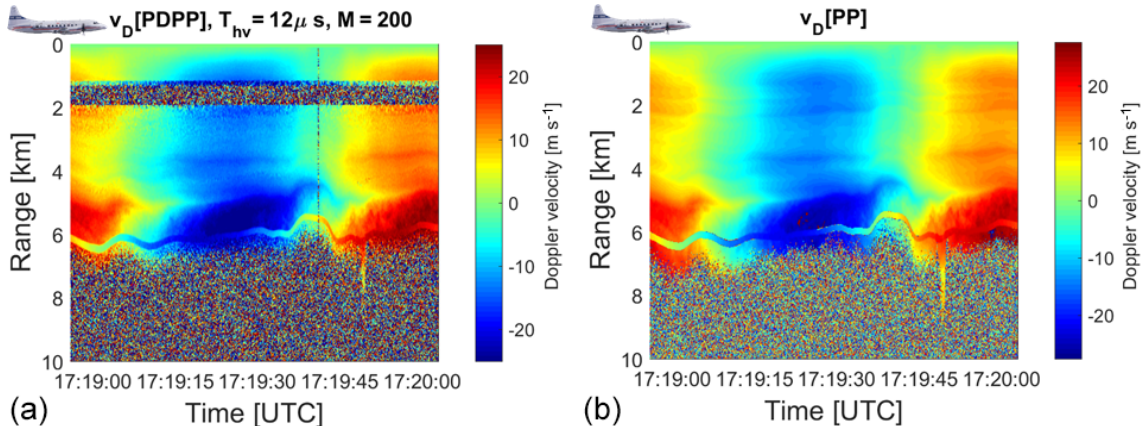
Figure 11. Velocity as measured by the PDPP technique with T hv = 12µs (a) and by the pulse-pair with two staggered pulse repetition times of 90 and 120µs (b)